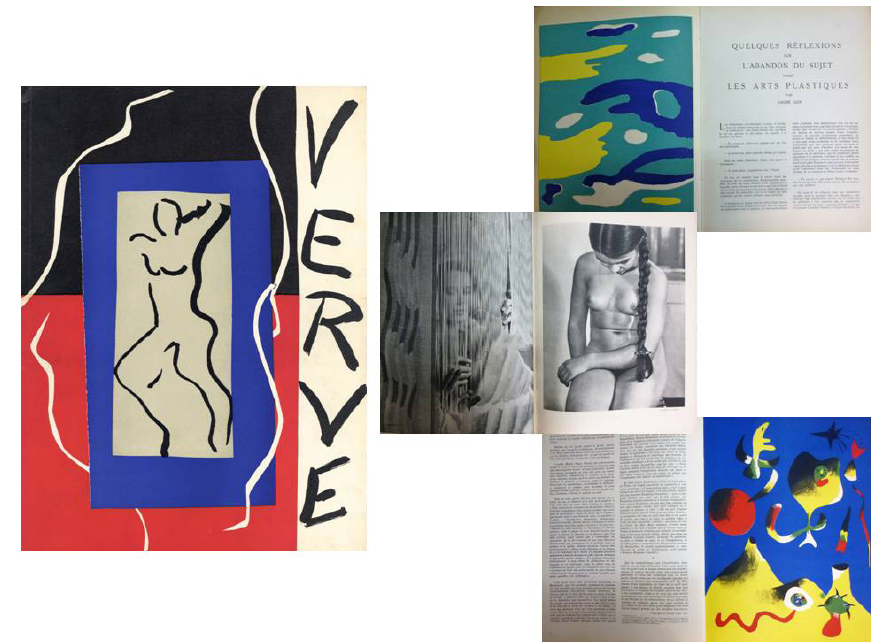
Couverture, illustrée par Henri Matisse, et pages du premier numéro de la revue Verve (décembre 1937), © ADGP, Paris, O